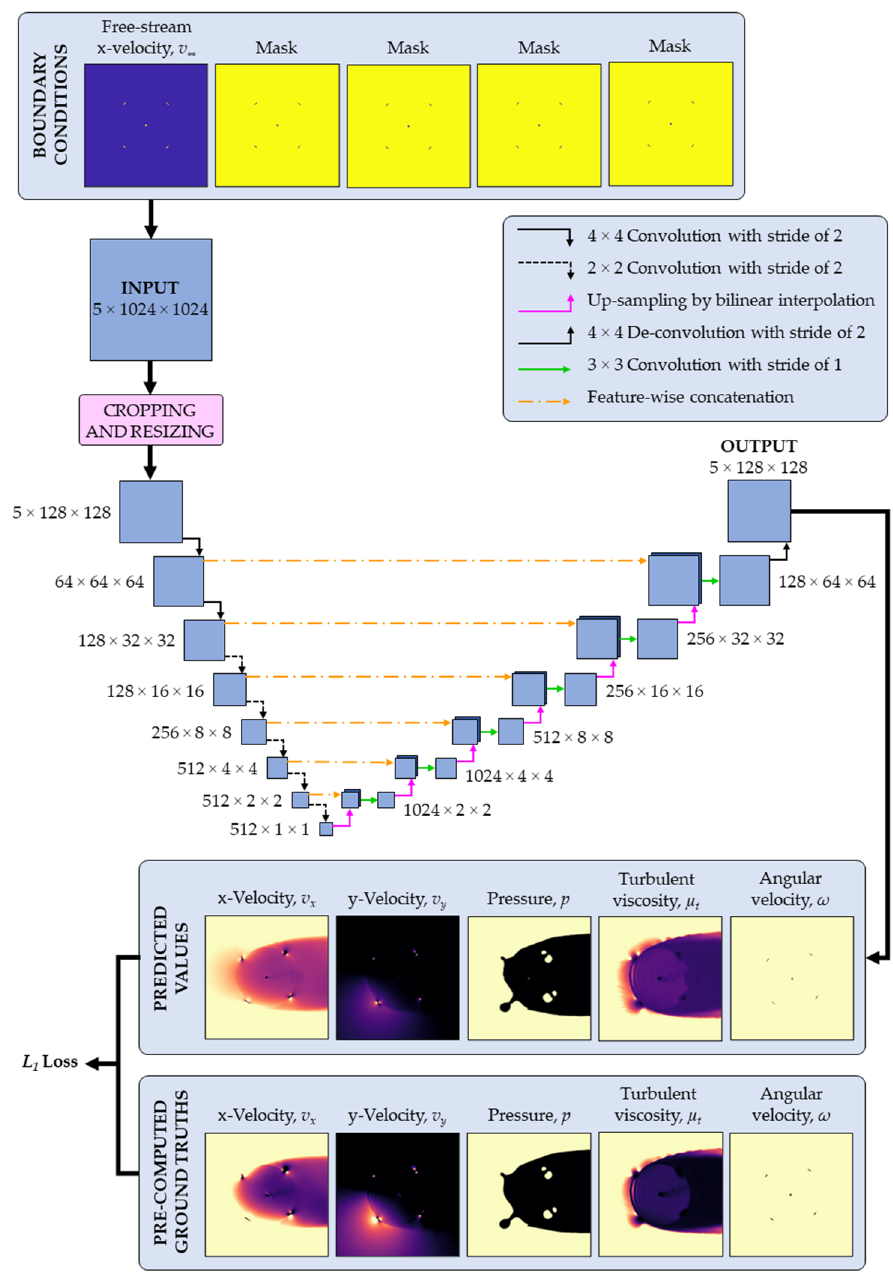
Figure 8. Small network